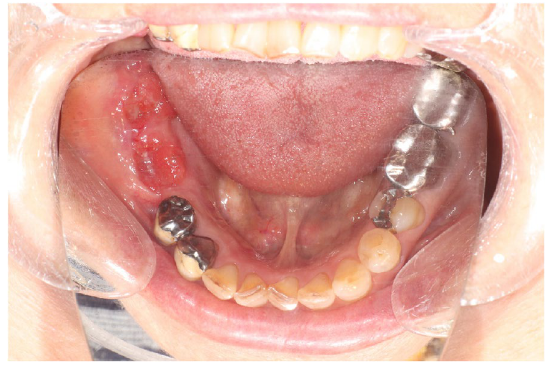
Fig. 1 Intraoral picture showing erythematous growth of the mandible. The growth was approximately 30 mm in diameter on the right side of the mandible extending from #44 to #47. #44 was not mobile